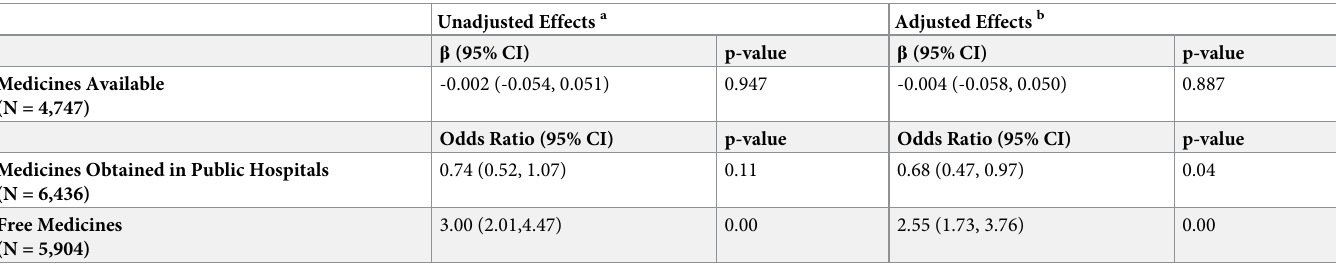
Table 2. Effect of UHC on outcomes of interest.